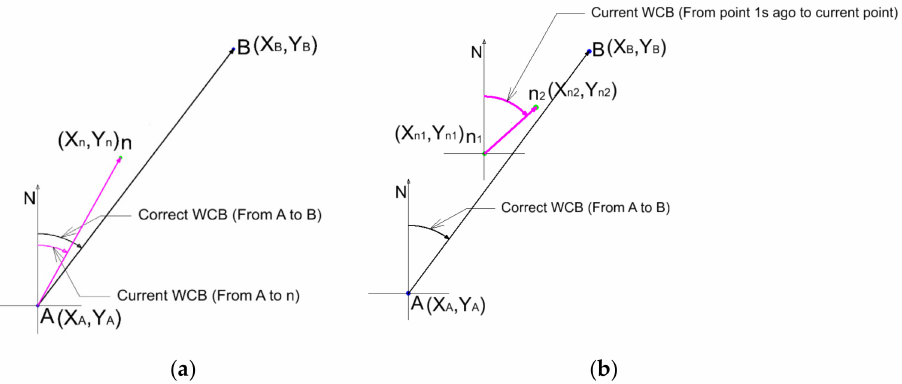
Figure 6. Illustrations of method 2 ( a ) and method 3 ( b